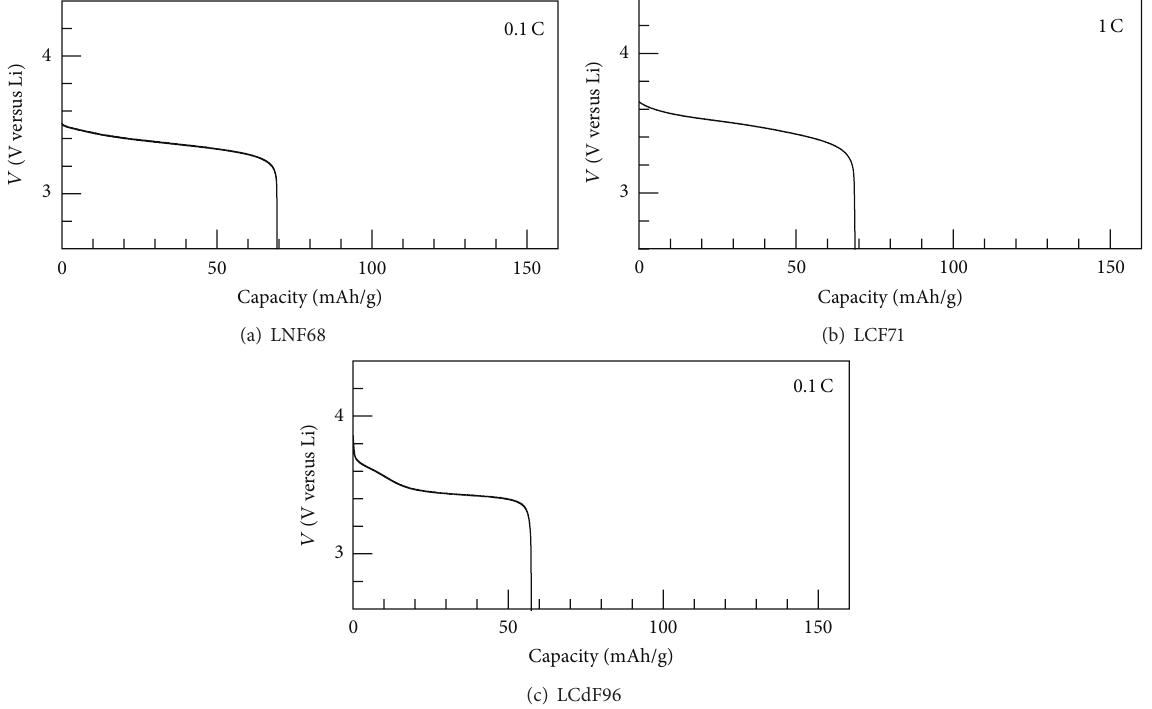
Figure 13: OCV discharge curves of (a) LNN68, (b) LCF71, and (c) LCdF96 films against Li (cited from